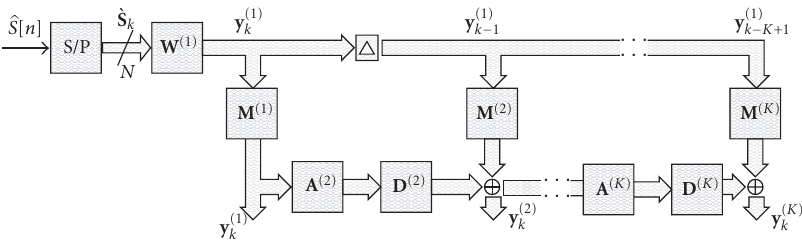
Figure 5: Low-complexity implementation of a matched filter bank high-performance GFSK receiver. The received GFSK signal (cid:6) s [ n ] is passed through a serial/parallel converter and a filter bank W (1) with a single bit duration. Processed over K stages, the matched filter bank outputs are contained in y ( K ) k